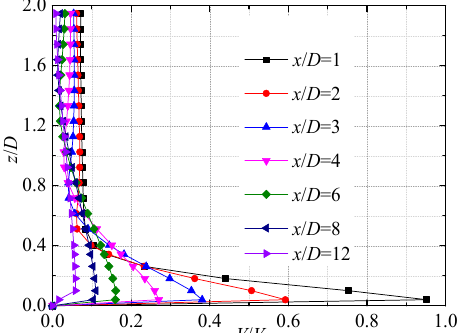
Figure 12. Variation of normalized average velocity V/V b .